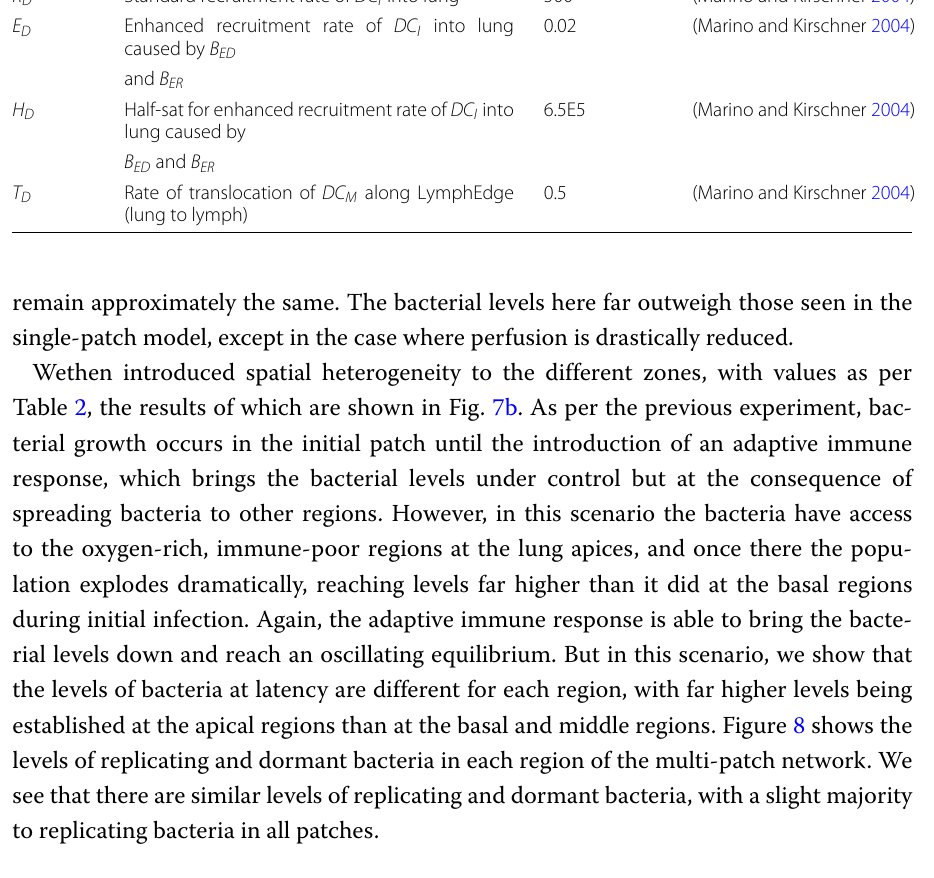
Table 5 Macrophage event parameters used for experiments, unless specified in the text Parameter Description Value (per